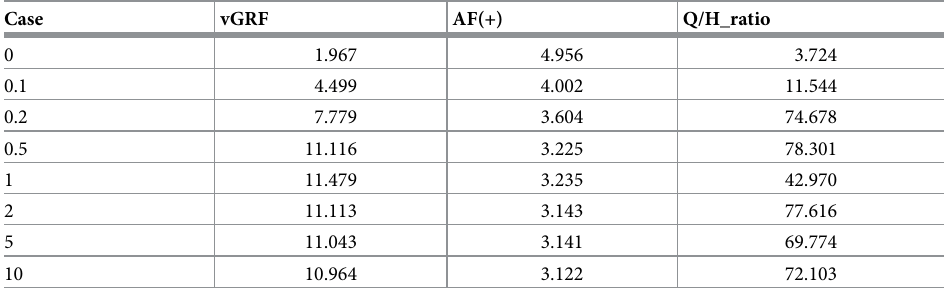
Table 11. Vertical GRF, AF, Q/H force ratio at peak vGRF time instance for the Moco Control goal weight case.